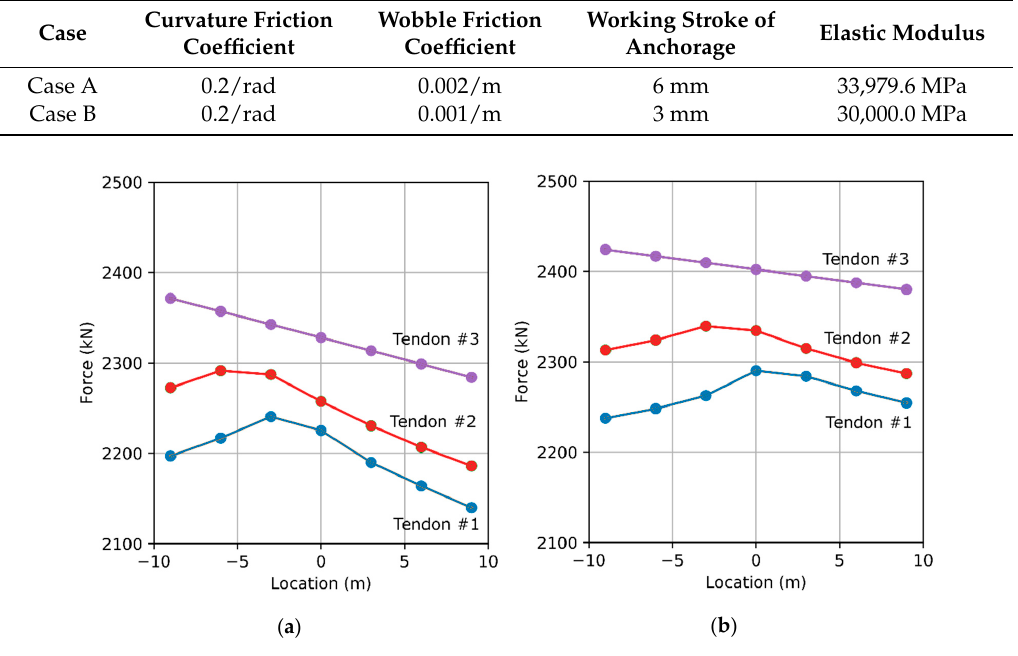
Figure 5. Comparison of tendon prestress force distributions per analysis case: ( a ) Case A; ( b ) Case B.